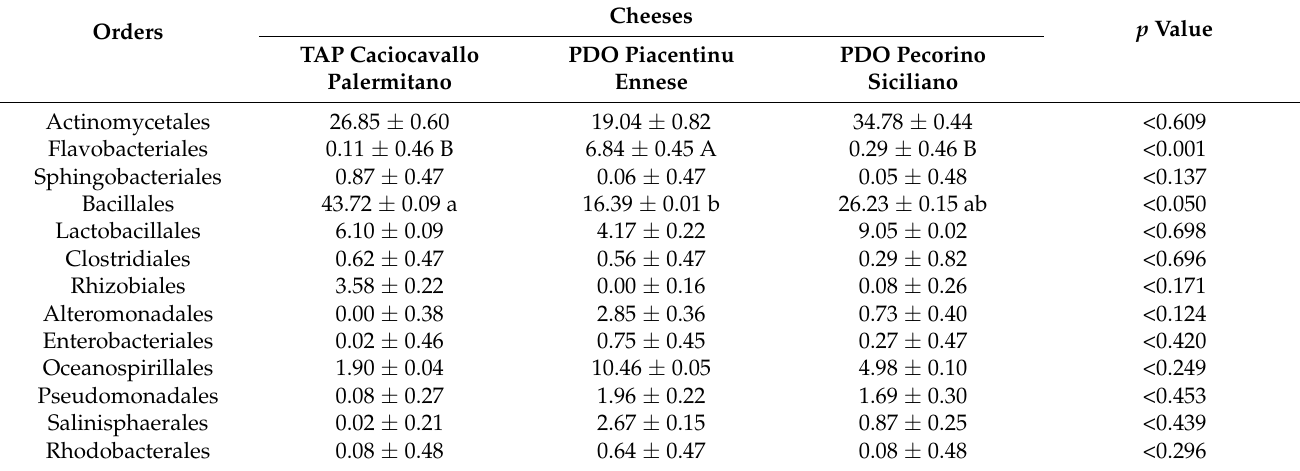
Table 3. Relative abundance (%) of operational taxonomy units (LSM ±